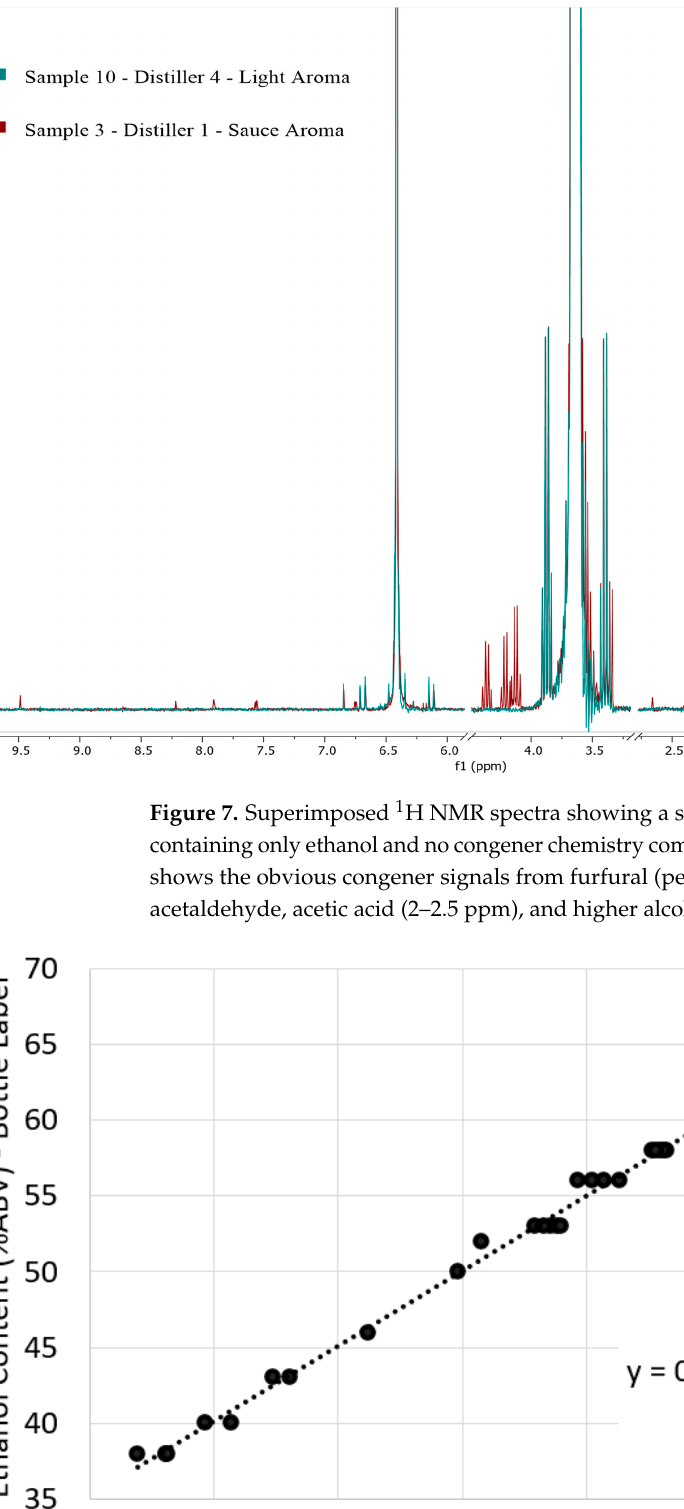
Table 2. Concentrations of ethanol and major congeners for 10 of the 30 baijiu samples analyzed.